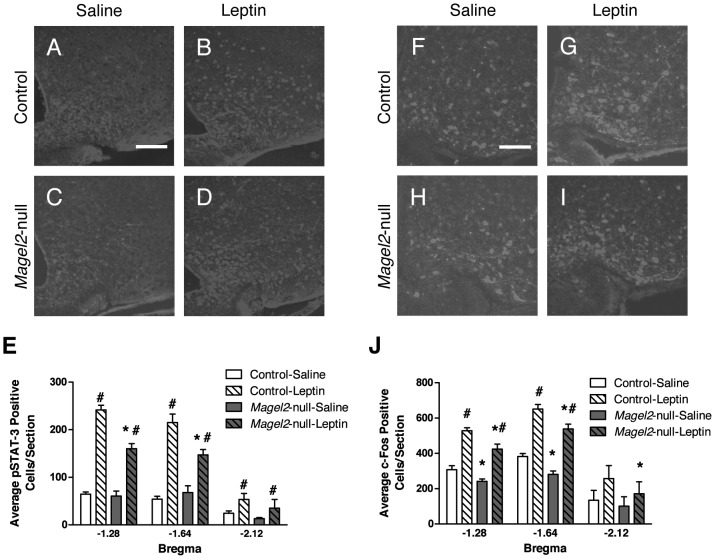
pSTAT3 and c-fos expression in ARC neurons in leptin-treated mice.A–D) Representative immunohistochemistry (IHC) images showing pSTAT3 immunoreactivity following ip PBS (saline) or leptin injection. Scale bar, 100 µm. E) Magel2-null mice have fewer pSTAT3 positive cells than control following leptin injection (Bregma −1.28, P<0.001; Bregma −1.64, P<0.005; Bregma −2.12, P>0.5, *compared between genotypes by Student's t-test) but both genotypes have more pSTAT3 positive cells after leptin treatment than after PBS (#, P<0.05, compared between treatments by Student's t-test; n = 8 mice of each genotype). F–I) Representative images of c-fos IHC following ip PBS and leptin injection. Scale bar 100 µm. J) Leptin induced c-fos expression in both Magel2-null and control mice compared to PBS (#P<0.05, compared between treatments by Student's t-test). At both baseline and following leptin treatment, Magel2-null mice had significantly fewer c-fos positive cells compared to controls (Bregma −1.28 ∼18% reduction, Bregma −1.64 ∼20% reduction, Bregma −2.12 ∼35% reduction, *P<0.05, compared between genotypes by Student's t-test). Values in E) and J) are means ± SEM.